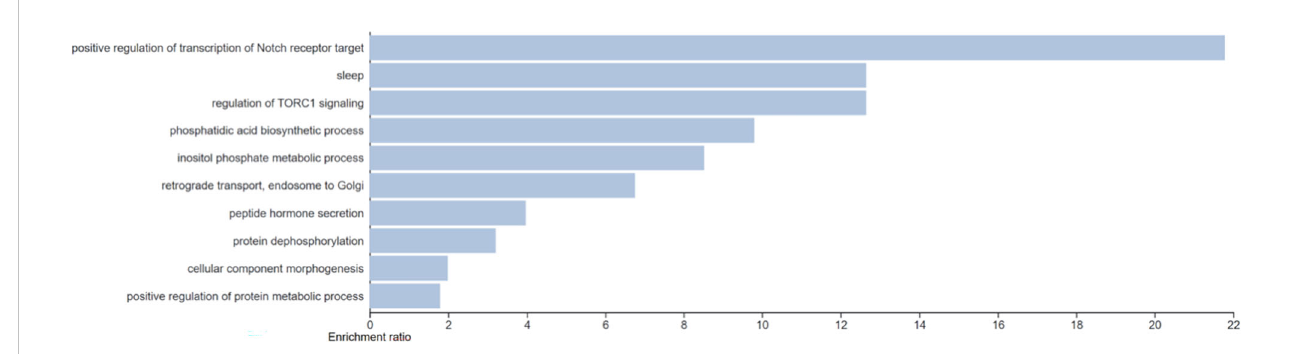
FIGURE 2 Gene ontology analysis of the genes with predictive capacity with clustering of the top 50 biological pathways via weighted set cover. 10 clusters of gene ontology were identi fi ed (0.0037 < p <